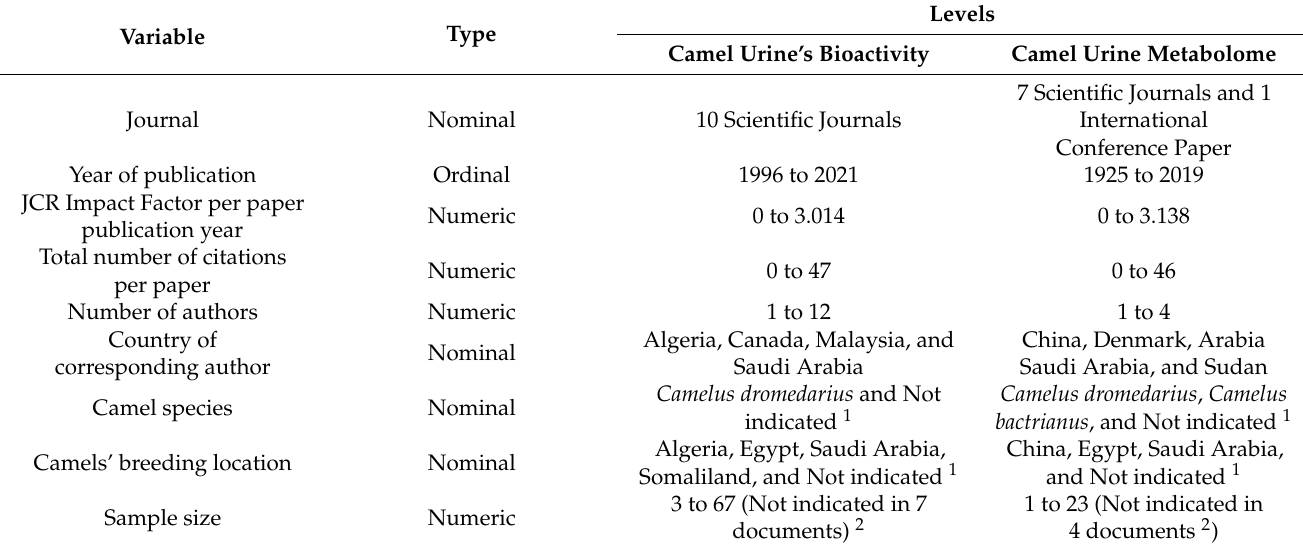
Table 1. Category description for bibliometric variables